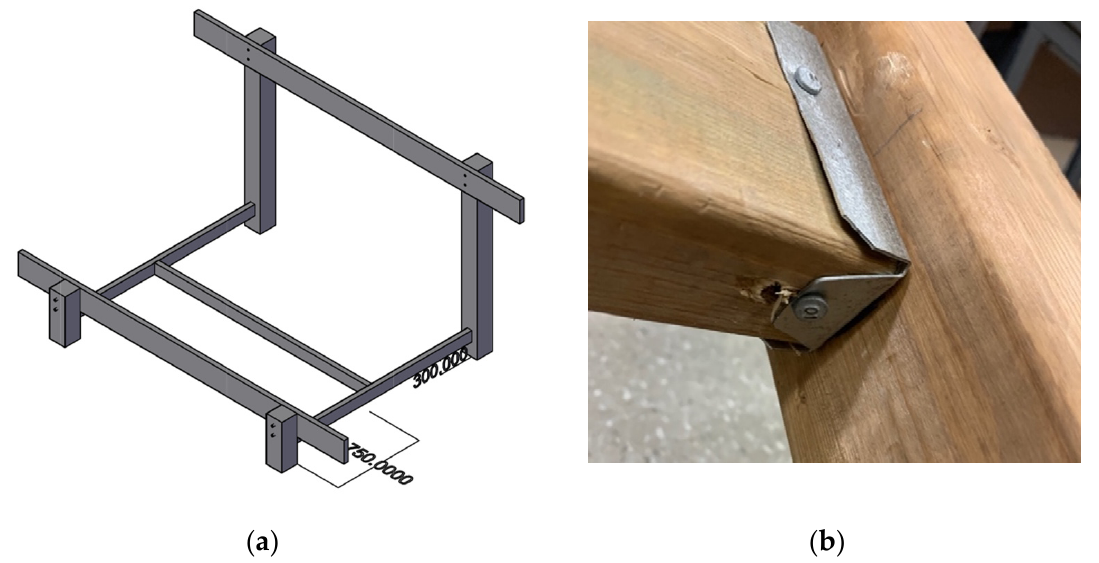
Figure 5. ( a ) Spacing for 2 × 4 bracing, and ( b ) 2 × 4 fence brackets, joist hanger nails, and screws used for connections.